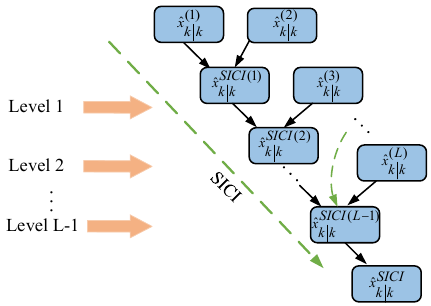
Figure 2. SICI fusion algorithm.